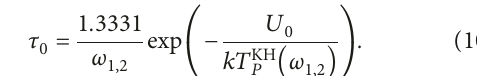
r max , (b) the peak KH in Zr on the 1 /T 0 . 5 ∓ Δ